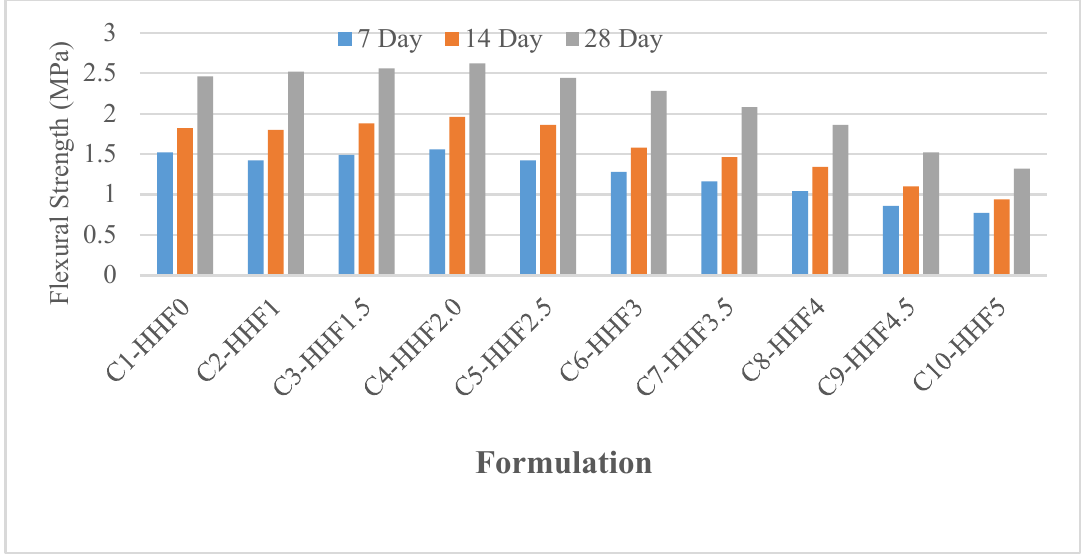
Figure 4. Flexural strength of concrete human hair fiber.